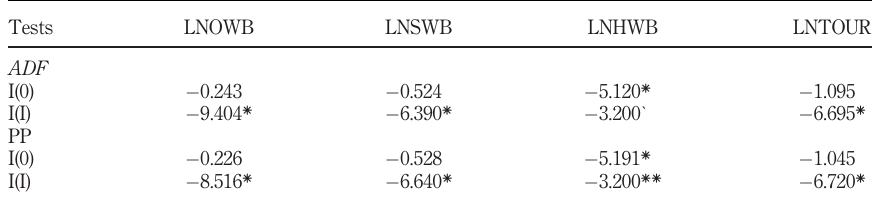
Table 4. Unit root tests